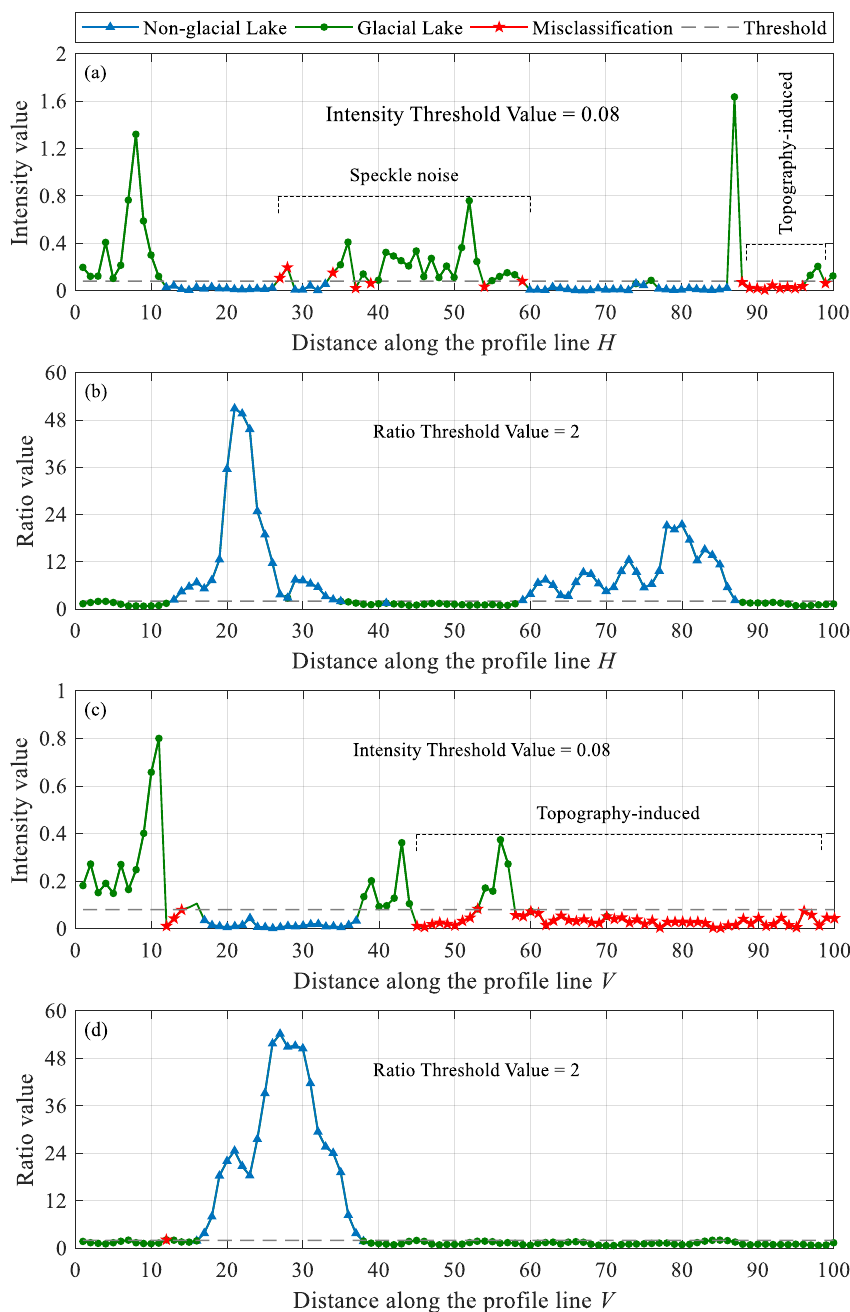
Figure 4. ( a , c ) show the distributions of intensity values along the yellow profile lines “H” and “V” in Figure 3b based on the intensity map, respectively. ( b , d ) show the profiles of the same lines corresponding to ( a , c ) in the ratio map, respectively. The green, blue, and red dotted lines represent non-glacial lakes, glacial lakes, and misclassification under the condition of using a threshold by manual.